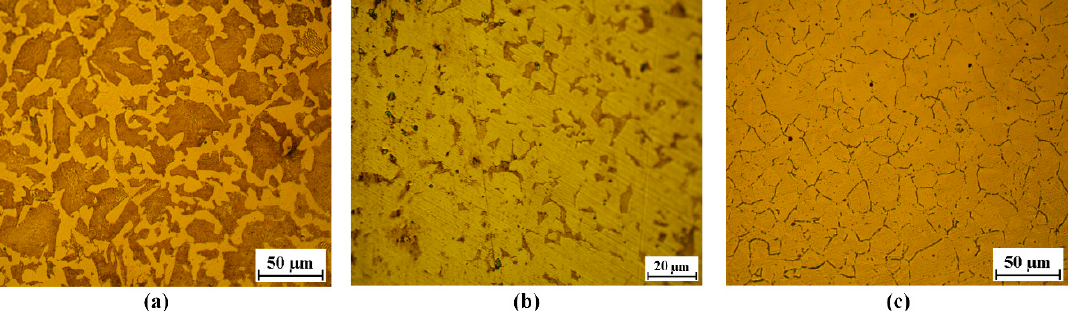
Figure 4. Metallographic structure of bar materials. ( a ) Q235 steel with Vickers hardness of 168.7 HV. ( b ) 40Cr steel with Vickers hardness of 260.1 HV. ( c ) 304 steel with Vickers hardness of 182.3 HV.